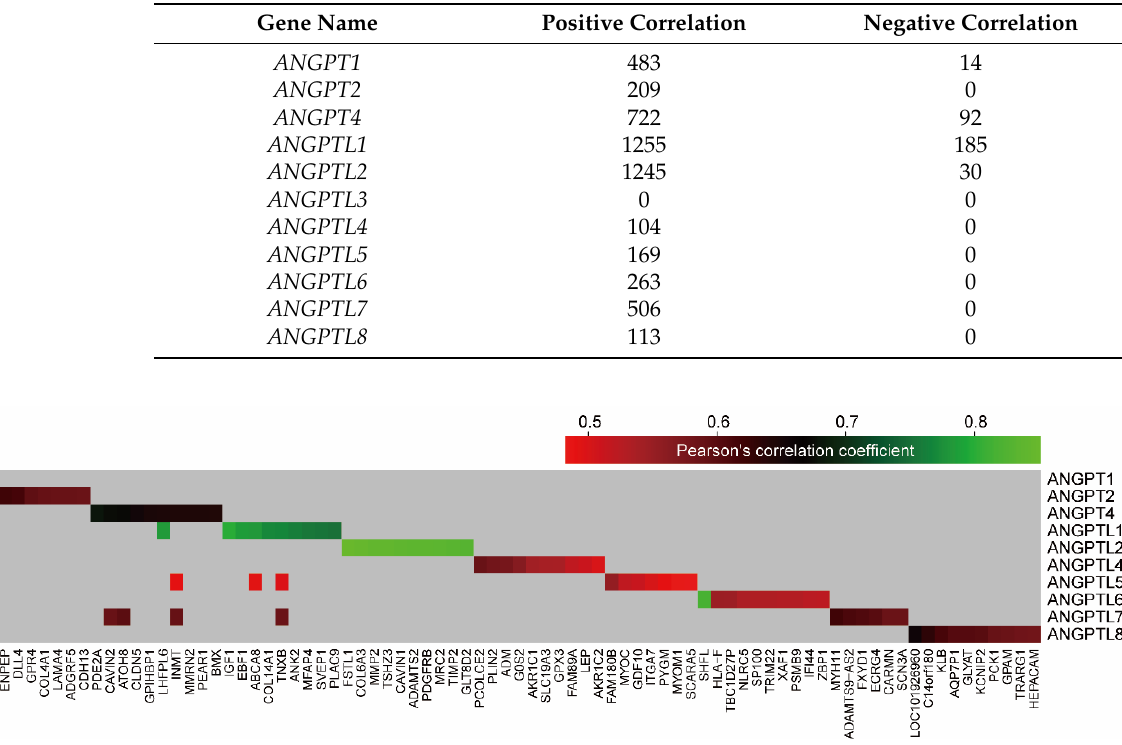
Figure 7. Top 10 genes that are positively correlated to each ANGPT/ANGPTL gene. For a complete list, refer to Table S2.